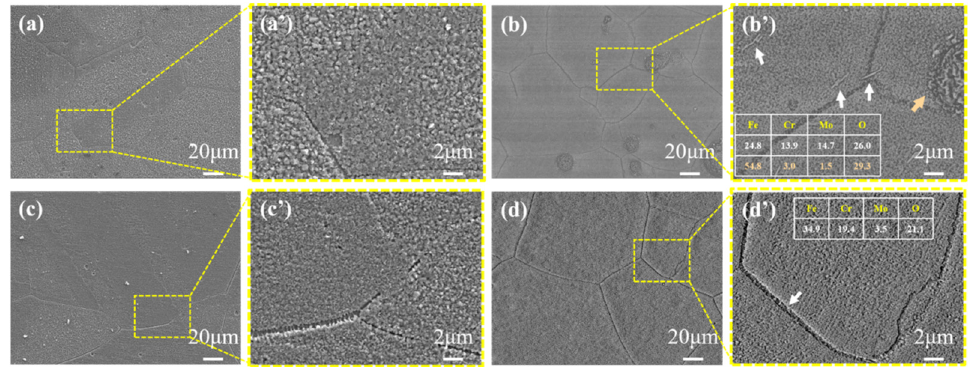
Figure 4. SEM surface morphologies of the 254SMO–0B ( a , b ) and 254SMO–40B ( c , d ) samples after oxidation at 1000 °C for 1.5min, 3min. ( a ʹ –d ʹ is the local amplification plot of the a–d )